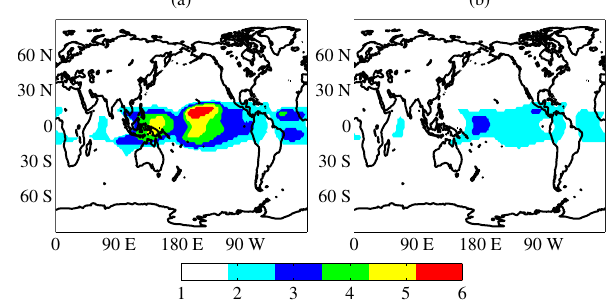
Figure 1. Persistence of the 200mb eddy geopotential height field of the 20th Century Reanalysis data from NOAA with (a) and with- out the EN34 component (b)